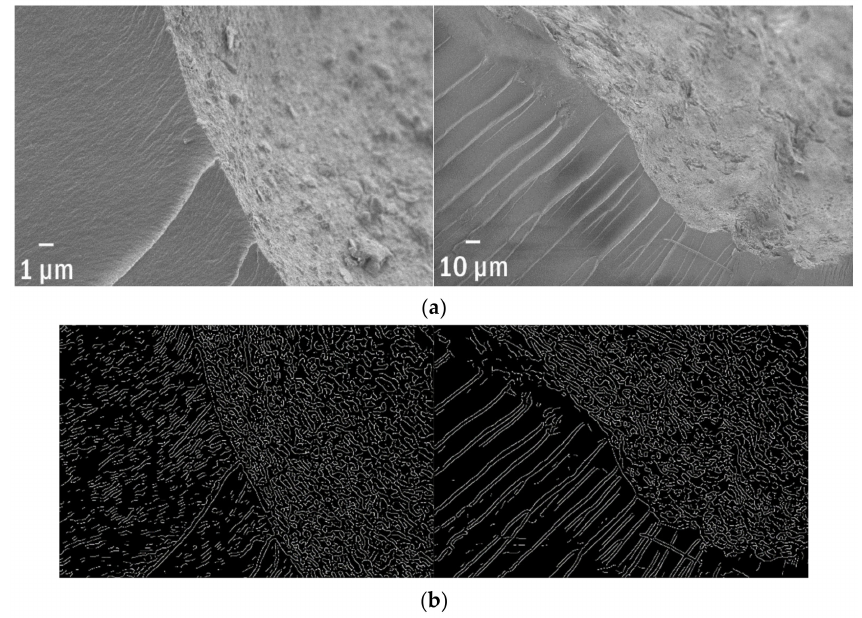
Figure 7. An aged green polypropylene formed at least ( a ) four different ecological niches on its surface, which are easily distinguishable by the ( b ) edges’